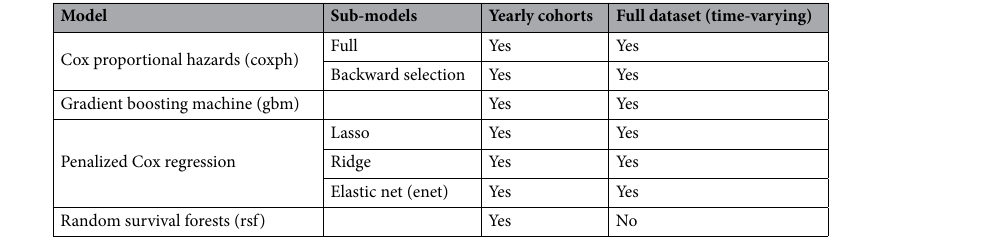
Table 1. A summary of trained